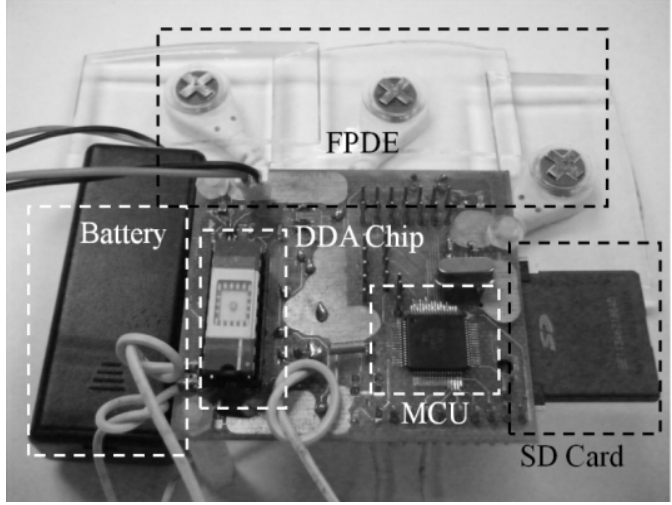
Figure 9. Picture of the proposed recording